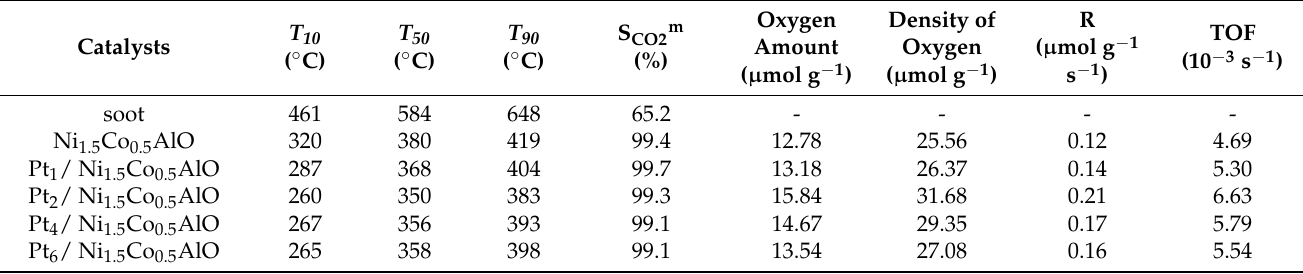
Table 1. Catalytic activities, densities of active oxygen, relative reaction rates (R), and TOF values